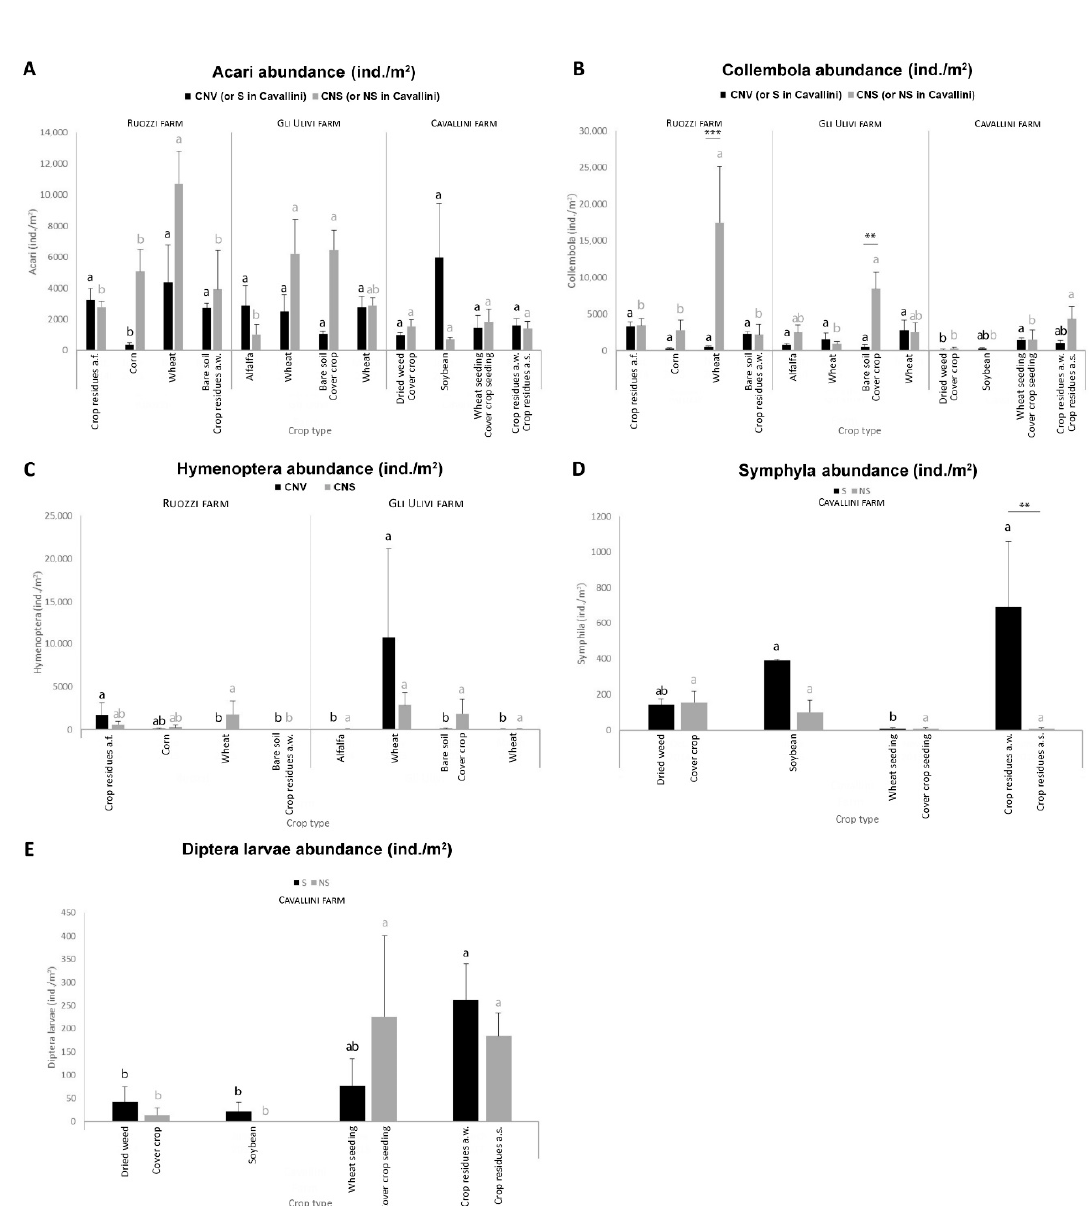
Figure 5. Barplots with standard errors of the abundance (ind./m 2 ) of the taxa that represent ≥ 3% of the total abundance of the soil fauna found in each farm. In the three farms, ( A ): Acari; ( B ): Collembola. In Ruozzi and Gli Ulivi farms, ( C ): Hymenoptera. In Cavallini farm, ( D ): Symphila; ( E ): Diptera larvae. Results for crop types are shown; after annual forage crop (a.f.), after wheat (a.w.), and after soybean (a.s.). In the legend, CNS: conservation (or NS: no sub-irrigation system) and CNV: conventional management (or S: sub-irrigation system). Within management, significance ( p ≤ 0.05) is indicated by different letters. Between management, significance is indicated with asterisks: ** p ≤ 0.01.